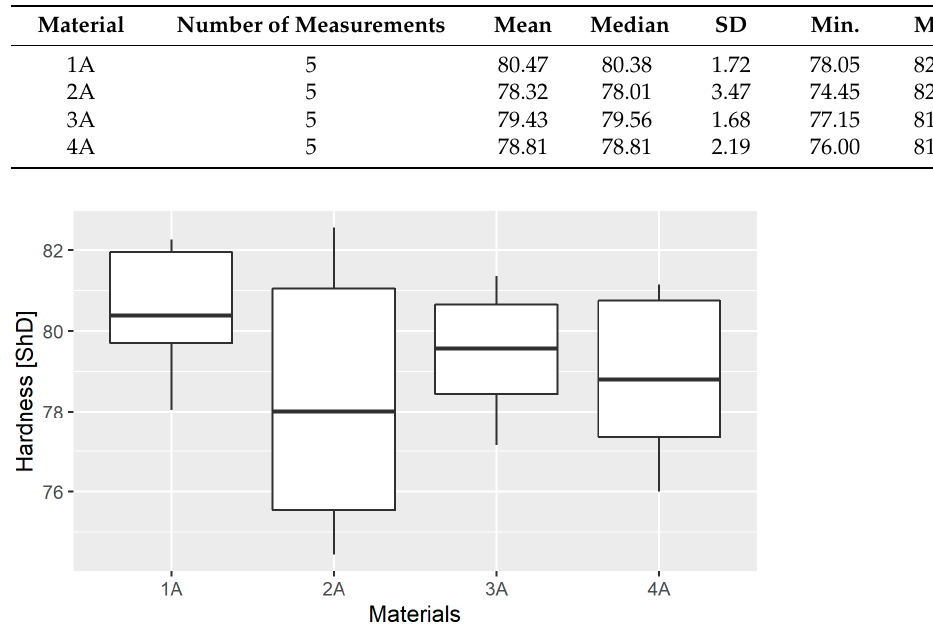
Table 1. Basic descriptive statistics of hardness measurement results in individual material groups.